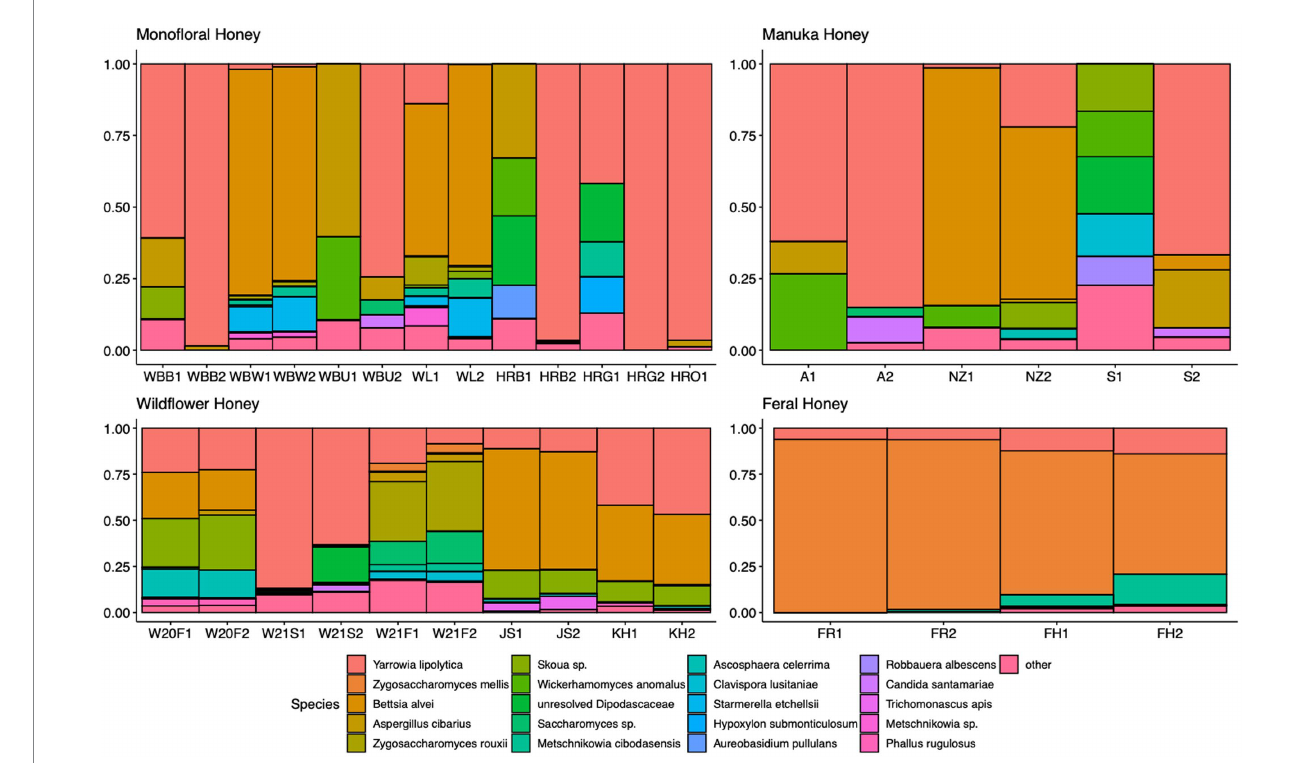
FIGURE 2 Honey fungal composition plot. ITS ASVs were agglomerated to the species level for each honey sample. Species with relative abundance higher than 0.3% across samples were selected and plotted. Species with less than 0.3% were agglomerated as “others.”